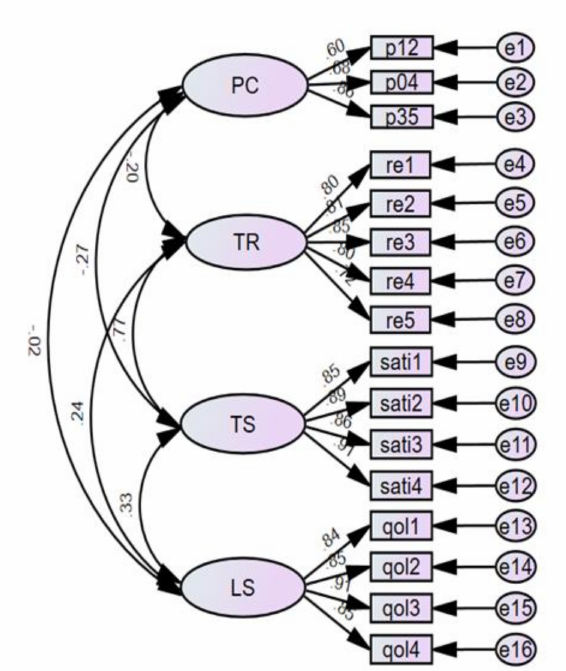
Figure 1. Standardized regression weights of the full measurement model. PC: perceived coercion, TR: therapeutic relationship, TS: therapeutic satisfaction, LS: life